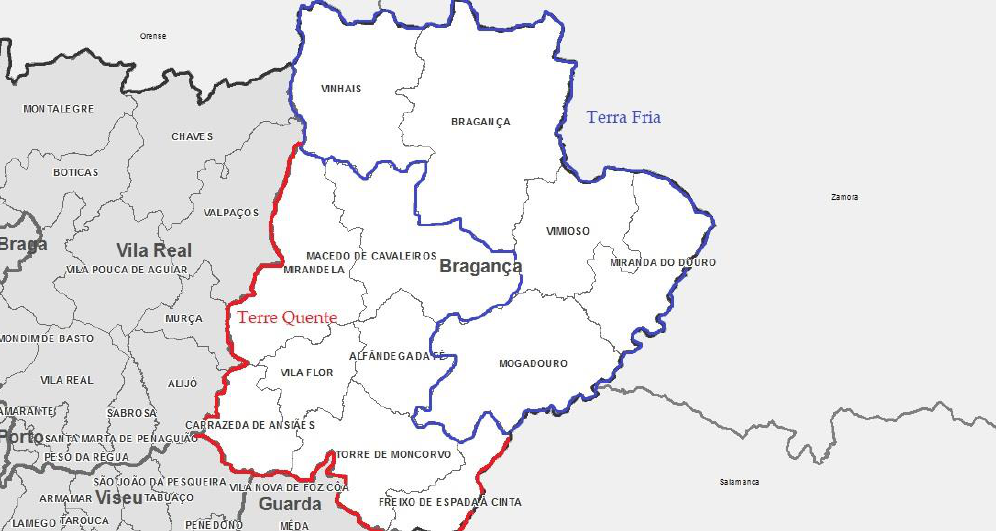
Figure 1. Map of the district of Bragança, with the regions of Terra Fria and Terra Quente. Source [24].